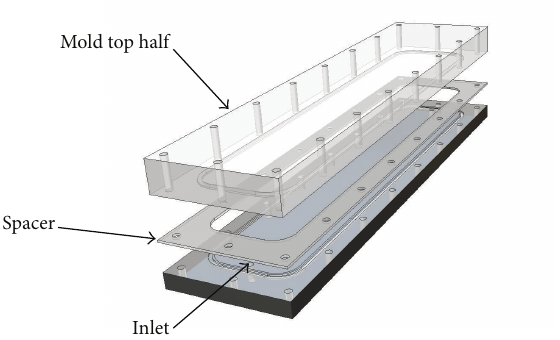
Figure 1: Mould assembly for the characterization of fiber preform